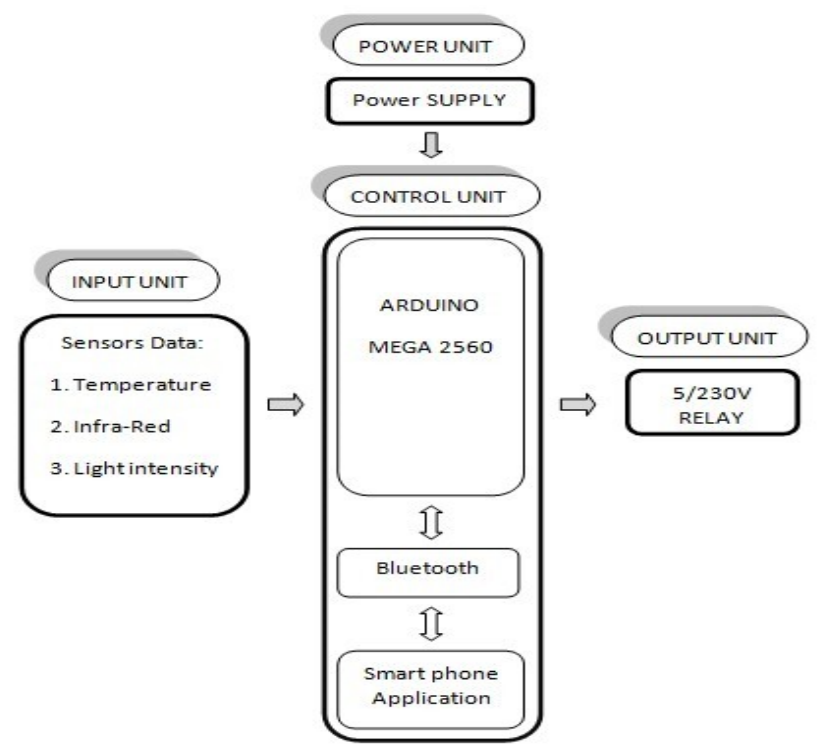
Figure 14. Block diagram of the proposed lighting control system [21].